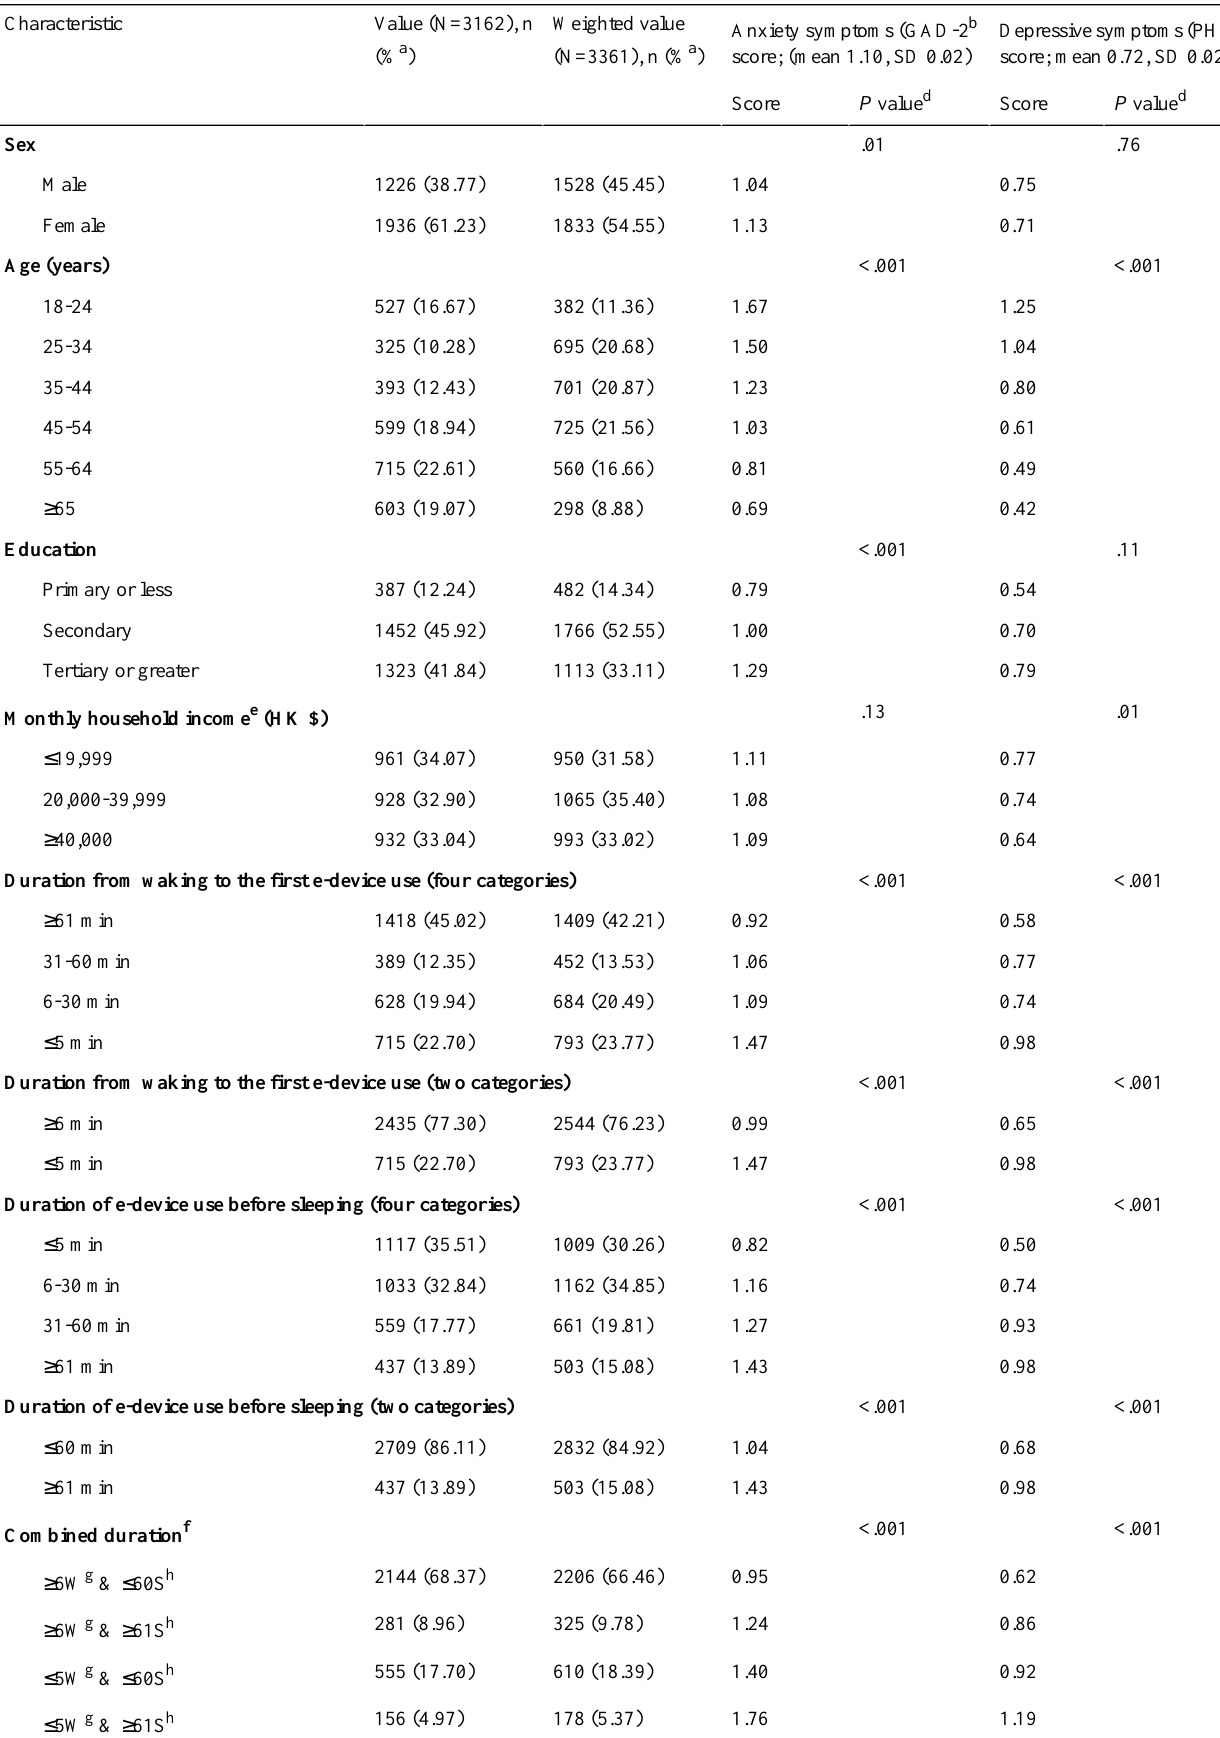
Table 1. Weighted mean scores of anxiety and depressive symptoms by sociodemographic characteristics in Hong Kong adults who used e-devices.